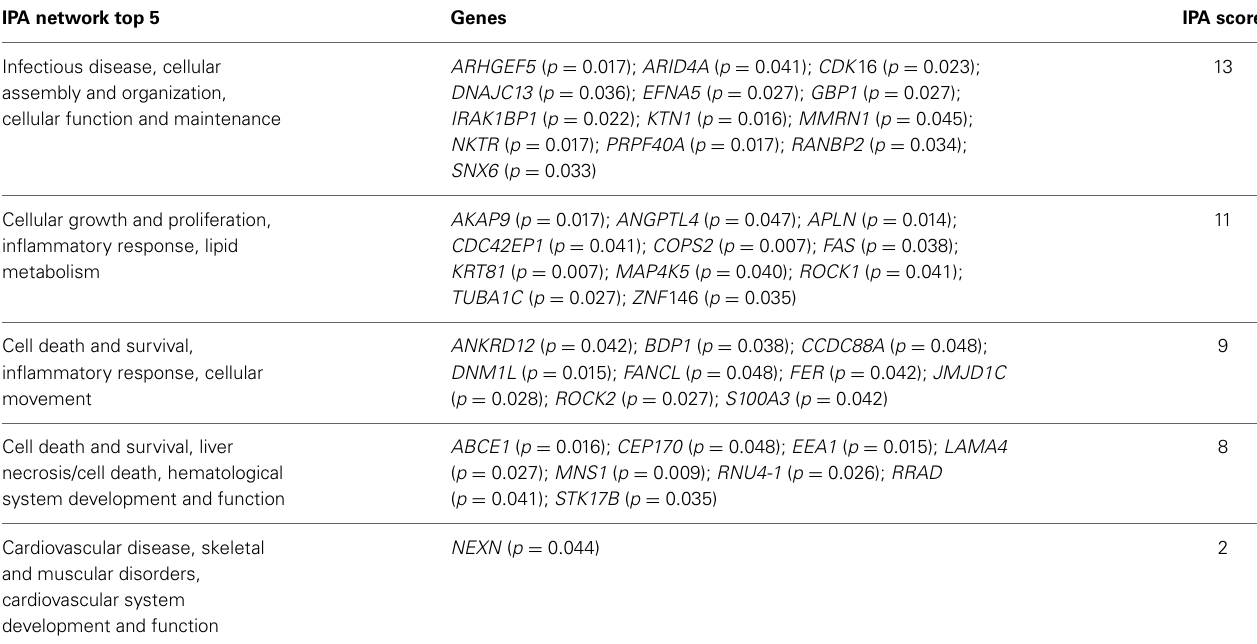
Table 9 | Enriched ingenuity pathway analysis (IPA) categories including differentially expressed genes in the SSRI group. IPA network top 5 Infectious disease, cellular